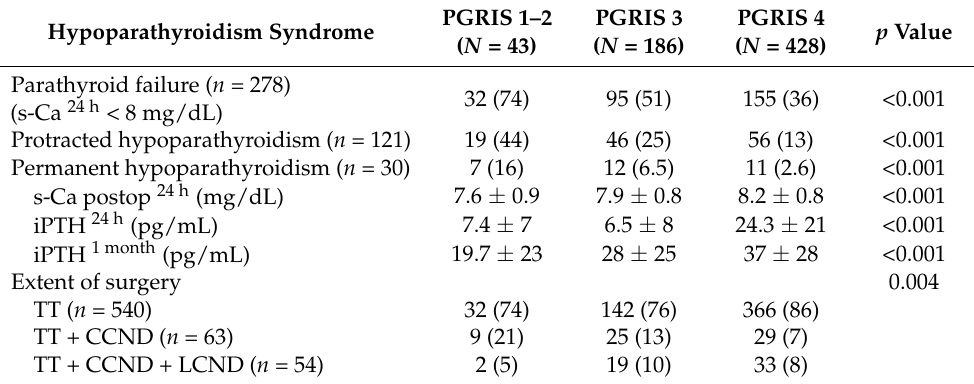
Table 3. Parathyroid glands preserved in situ (PGRIS) and postoperative parathyroid function after 657 total thyroidectomies (modified from ref.